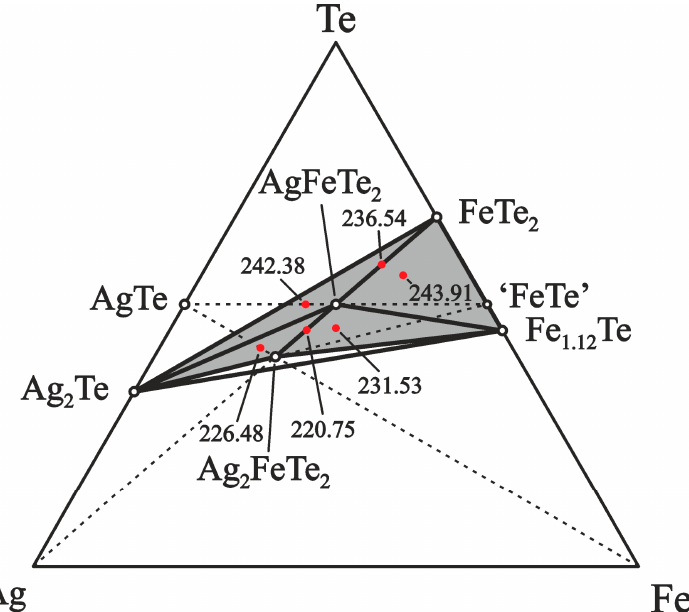
Figure 2. Equilibrium phase relations in the Ag–Fe–Te system below 500 K in the Ag 2 Te–FeTe 2 – Fe 1.12 Te (I) part. The dashed and solid tie lines indicate 2-phase equilibria and the red dots indicate phase compositions of the positive electrodes of the ECCs. For some phase regions, EMF values in mV at 460 K are given.